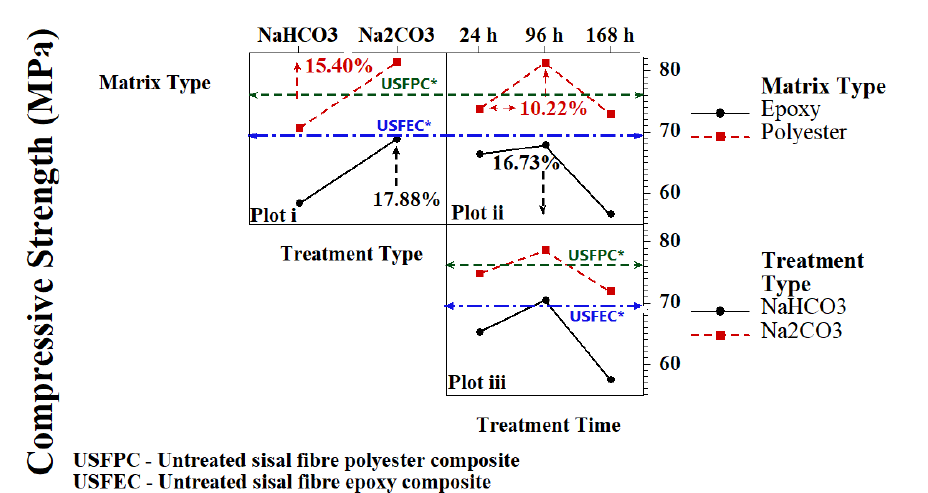
Figure 5. Impact testing (out of plane) interaction plot.